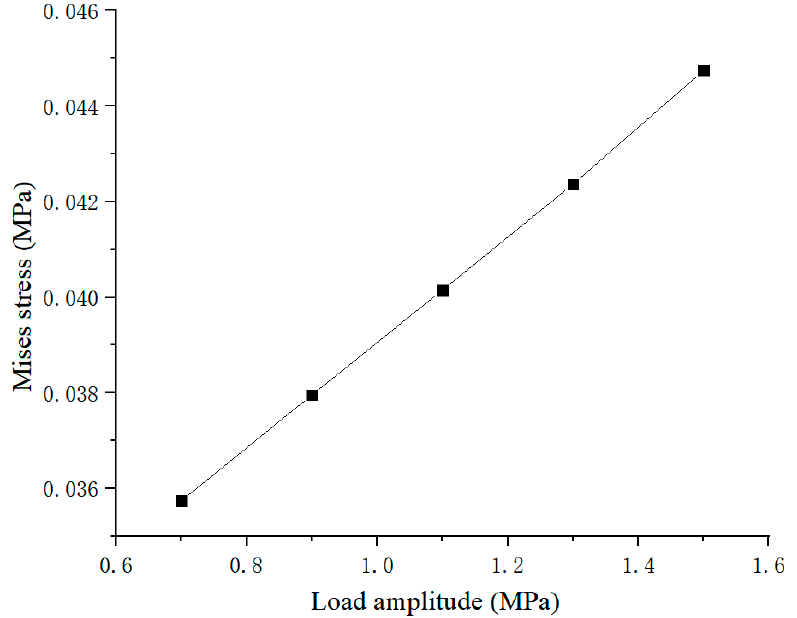
Figure 14. Variation of wall Mises stress at 14.625 m under different load amplitudes.